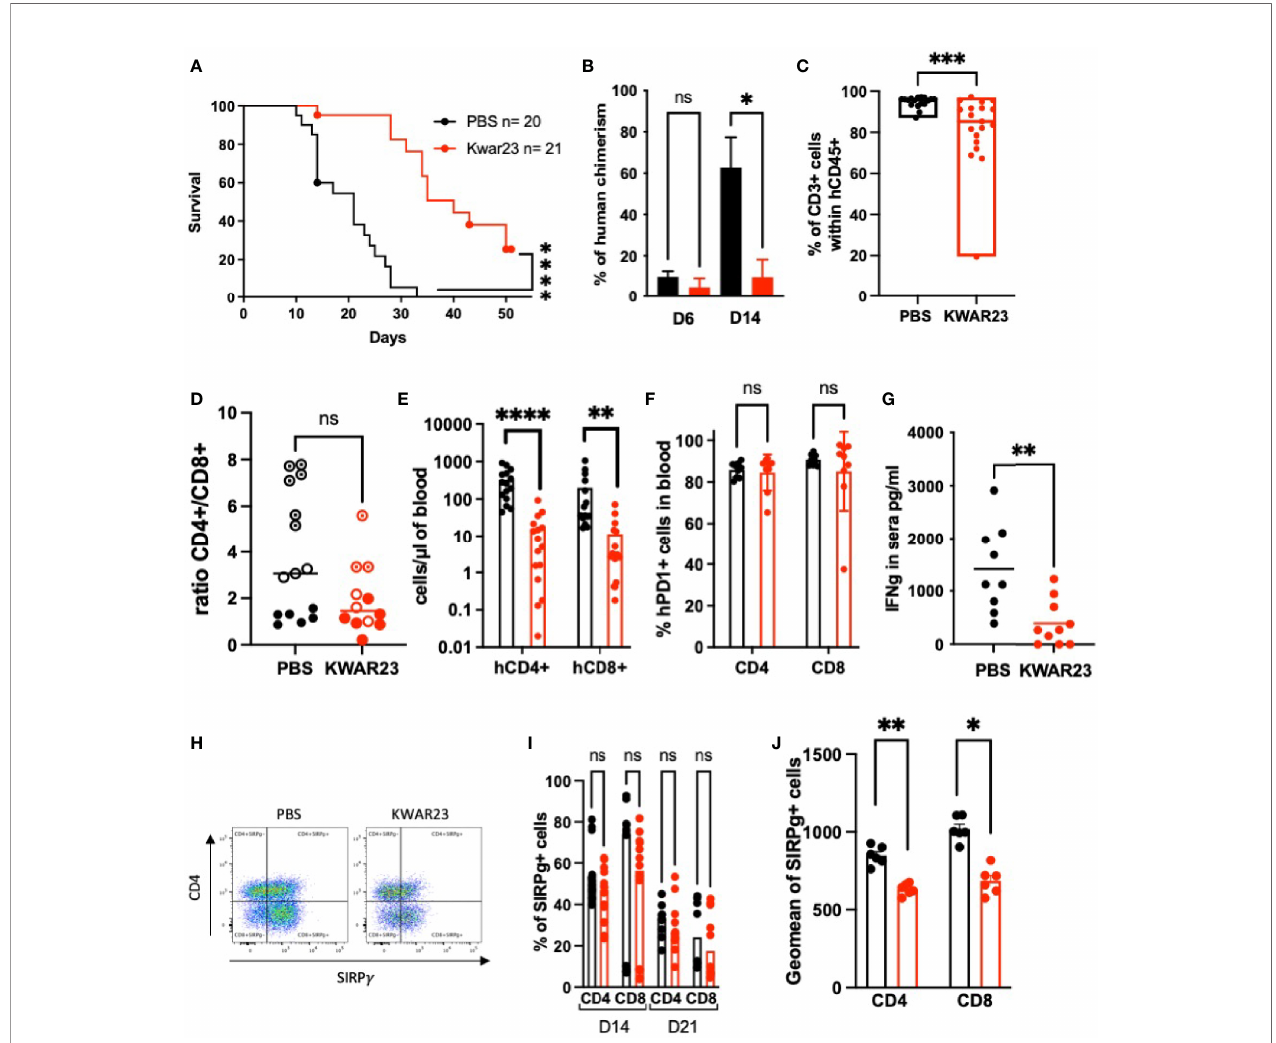
FIGURE 6 | Inhibition of SIRP a - g /CD47 interactions in vivo impairs human chimerism and delays xeno-GvHD. Recipient mice, irradiated at 1.5 Gy on Day 0, were injected i.v. with 10 million human PBMC 8 h later. Mice were i.p. treated 2×/week with the anti-SIRP a - g mAb (KWAR23) at 5 mg/kg or with PBS until they reached notable clinical signs of xeno-GvHD. (A) Mice survival is shown regarding treatment. Data were analyzed with a Log-rank (Mantel-Cox) test. (B) Kinetics of human chimerism. Data were analyzed with a one-way ANOVA test followed by Kruskal-Wallis. (C) Percentage of human T cells within the human CD45+ population analyzed in the blood at D14; PBS-treated mice are presented in black, and KWAR23-treated mice are presented in red. Data were analyzed with a Mann-Whitney test. (A – C) Results from four experiments are presented in which human PBMC from four different healthy volunteers were injected in four to fi ve mice per group. (D) CD4/CD8 ratio (percentage of positive cells within hCD45 population) was analyzed at D14 regarding the treatment. Data were analyzed with a Mann-Whitney test. n = 3 experiments with PBMC from three different HV donors (shown in different shape). (E) Absolute number of human CD4 and CD8 in the blood of recipient mice at Day 14. n = 3 experiments with PBMC from three different HV. Data were analyzed with a one-way ANOVA test followed by Kruskal-Wallis. (F) PD1 + cells within the circulating human CD4 and CD8 T cells; data were analyzed with a one-way ANOVA test. (G) IFN- g dosage sera collected at Day 14 are shown; data were analyzed with a Mann-Whitney test. (H) Representative dot plots of human CD45 + CD3 + in blood of humanized mice treated with PBS or KWAR23; SIRP g expression on CD4 + and CD8 T cells (i.e., CD4 − ) is presented. (I) Percentage of SIRP g + CD4 + and SIRP g + CD8 + cells are shown and were analyzed with a one-way ANOVA test. (J) SIRP g geometric mean on human CD4 and CD8 T cells. Data were analyzed with a one-way ANOVA test followed by Kruskal-Wallis. * p ≤ 0.05; ** p ≤ 0.01; *** p ≤ 0.001; **** p ≤ 0.0001; ns, not signi fi